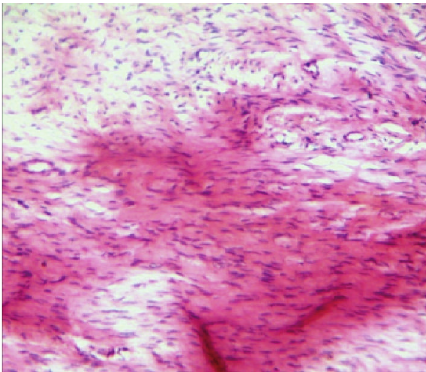
Figure 5: Haematoxylin and eosin stain (40x) showing spindle shaped cells with wavy nuclei and collagen fibres within a myxoid stroma.